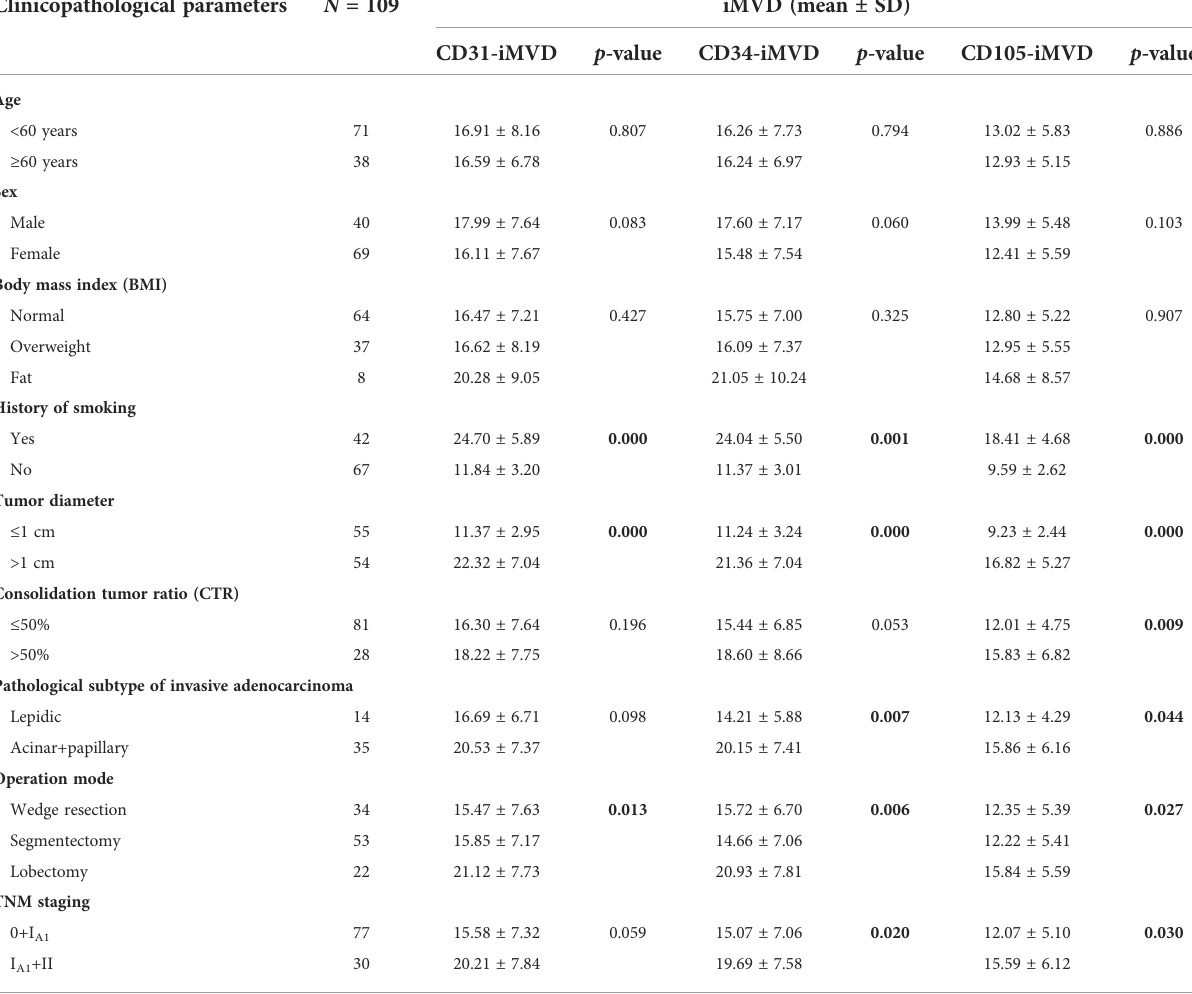
Bold indicates signi fi cance values